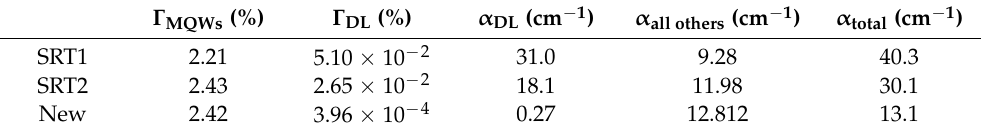
Table 1. Summary of 1D mode simulation results between SRT1 and SRT2, and the structure “New” with better optimized waveguide/cladding